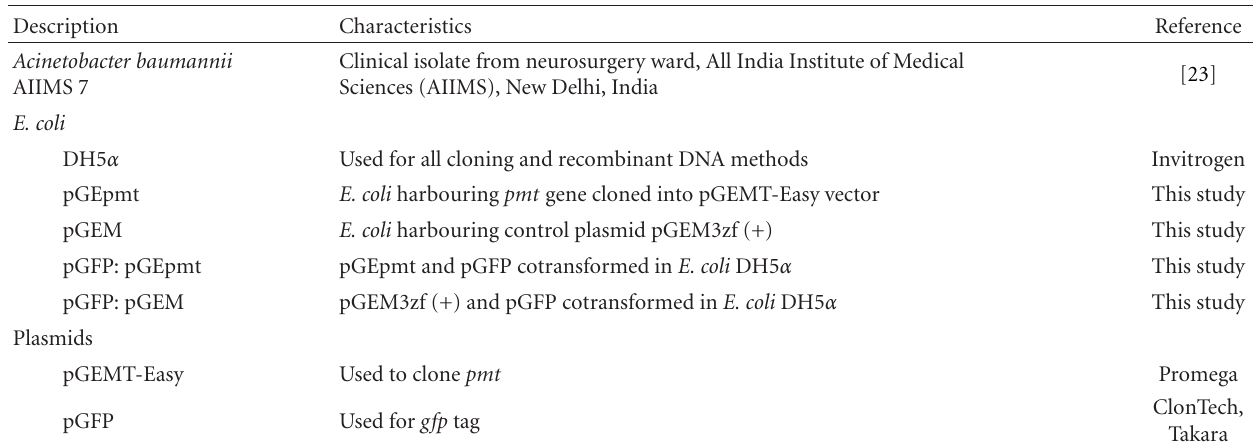
Table 1: Strains and plasmids used in the